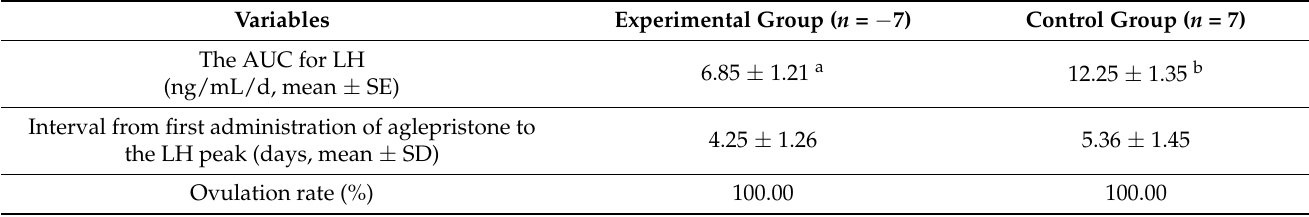
Table 1. The AUC for LH, interval from the first administration of aglepristone to the LH peak, and ovulation rate in experimental and control bitches.